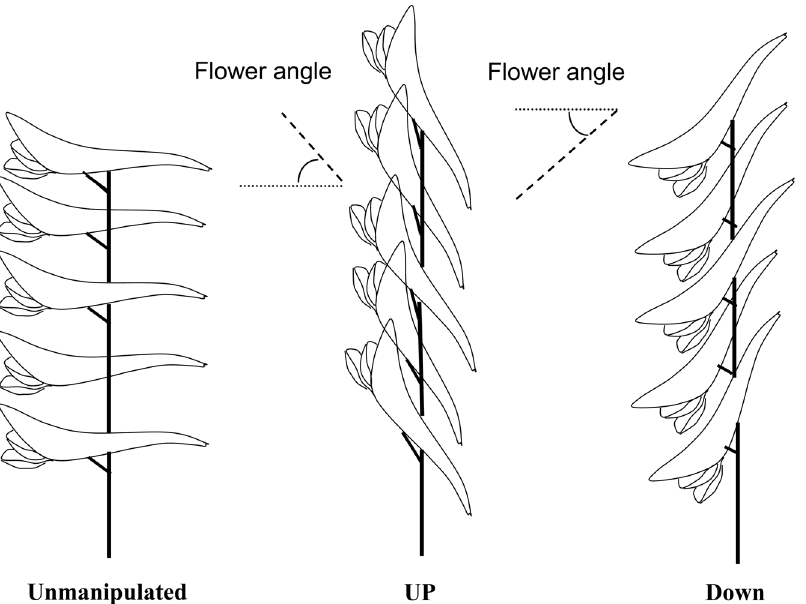
Figure 1. Side views of the three inflorescence types: horizontal (Unmanipulated), upward-facing (Up), and downward-facing (Down). The positive or negative angles between a flower’s main axis and the horizontal indicate the floral orientation. The flower angle was manipulated by leaning the pedicel of individual flowers and taping the terminal of the spur to the inflorescence stalk.